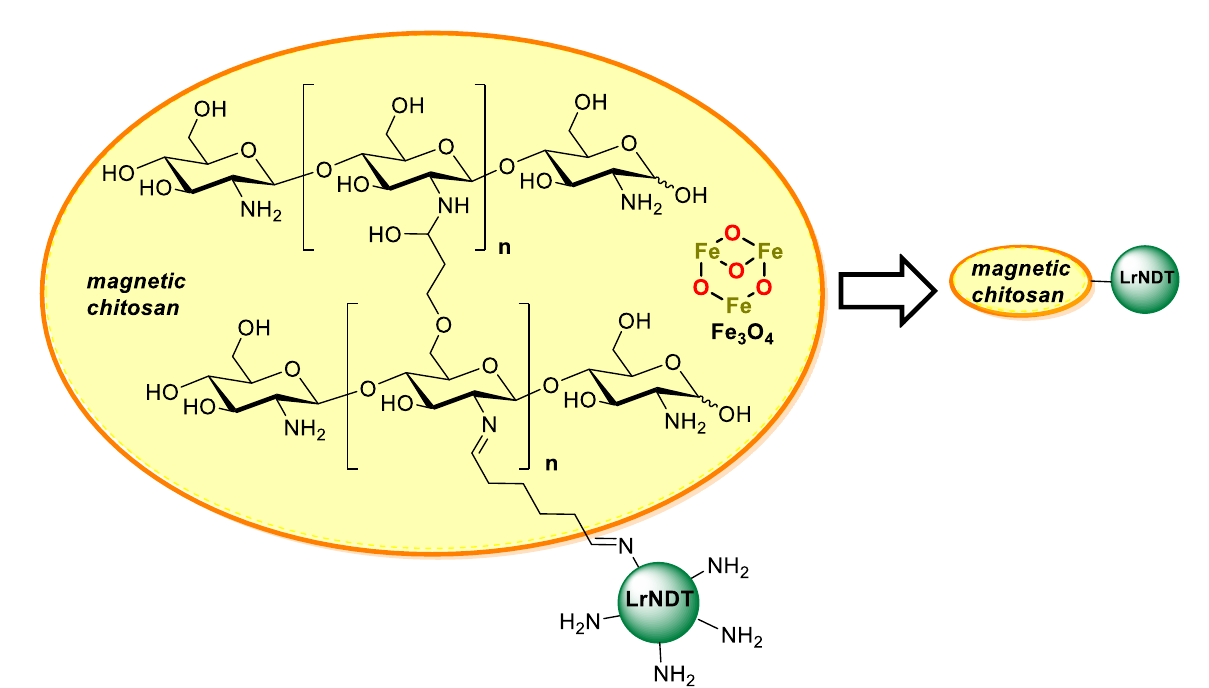
Figure 7. Schematic representation of the immobilization of a recombinant nucleoside 2’ -deoxyribosyltransferase from Lactobacillus reuteri (LrNDT) on cross-linked magnetic chitosan beads. Adapted from Fernández-Lucas et al. [165].